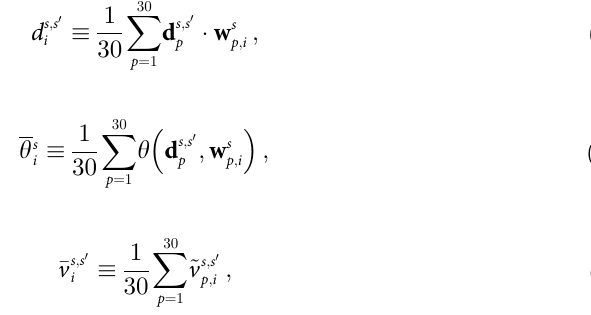
where ~ v s ; s 0 is the percent of variance explained of stimulus group p in session s 0 along the i p ; i